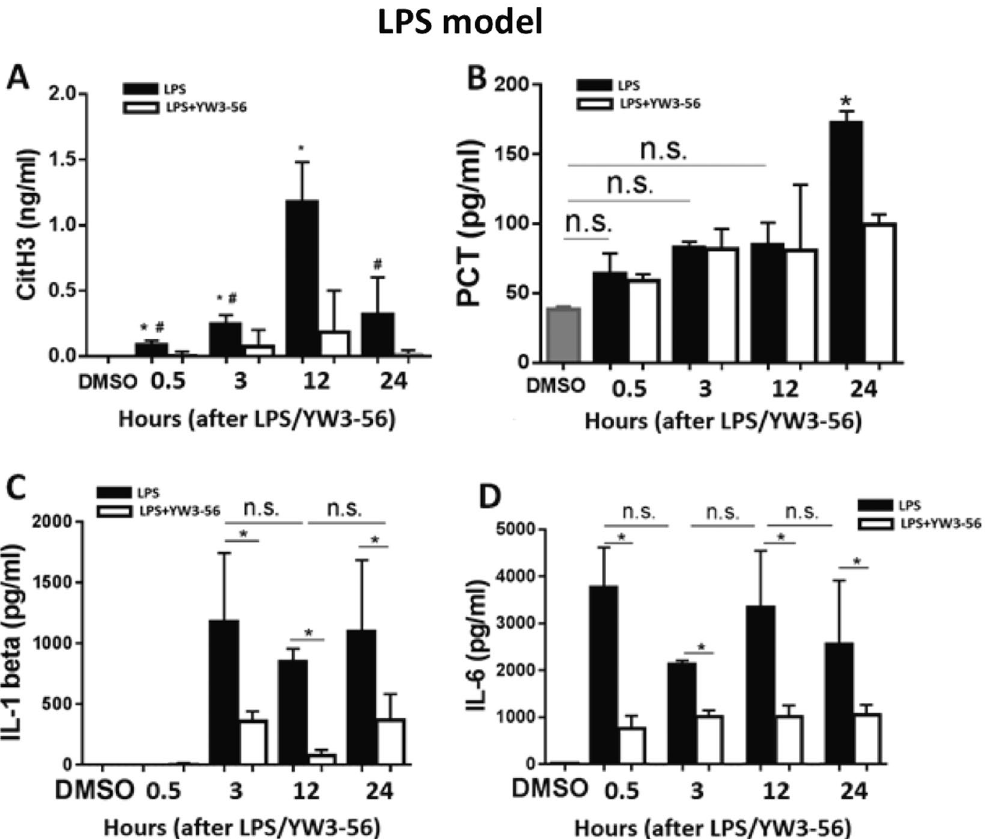
Figure 3. CitH3 is a sensitive and long-lasting biomarker compared to PCT, IL-1 β and IL-6 in LPSS. Mice were intraperitoneally administrated LPS (35 mg/kg) with or without YW3-56. Sera were prepared at 0.5, 3, 12 and 24 hours after LPS for measurement of CitH3 ( A ), PCT ( B ), IL-1 β ( C ) and IL-6 ( D ) by ELISA. ( A ) Circulating CitH3 was detected quickly (0.5 hour), accumulated maximally at 12 hours, and sustained for 24 hours. YW3-56 significantly attenuated LPS-induced increase of CitH3. * p < 0.05 compared to DMSO, # p < 0.05 compared to 12 hours post LPS. ( B ) LPS could not induce a significant increase of PCT in blood in the early stage of endotoxic shock (0.5, 3 and 12 h) till 24 hours compared to DMSO group ( p < 0.0001). ( C and D ) Pro- inflammatory cytokines irregularly fluctuated after LPS administration (IL-1 β & IL-6). They did not respond to LPS early (IL-1 β ), although they were attenuated by YW3-56 treatment. Data was shown as mean ± standard deviation (SD) (n = 3–5/group). IL-1 β : interlukine-1 β ; IL-6: interlukine-6; CitH3: Citrullinated histone H3; LPS: Lipopolysaccharide; DMSO: dimethyl sulfoxide. PCT: procalcitonin; LPSS: LPS-induced endotoxic